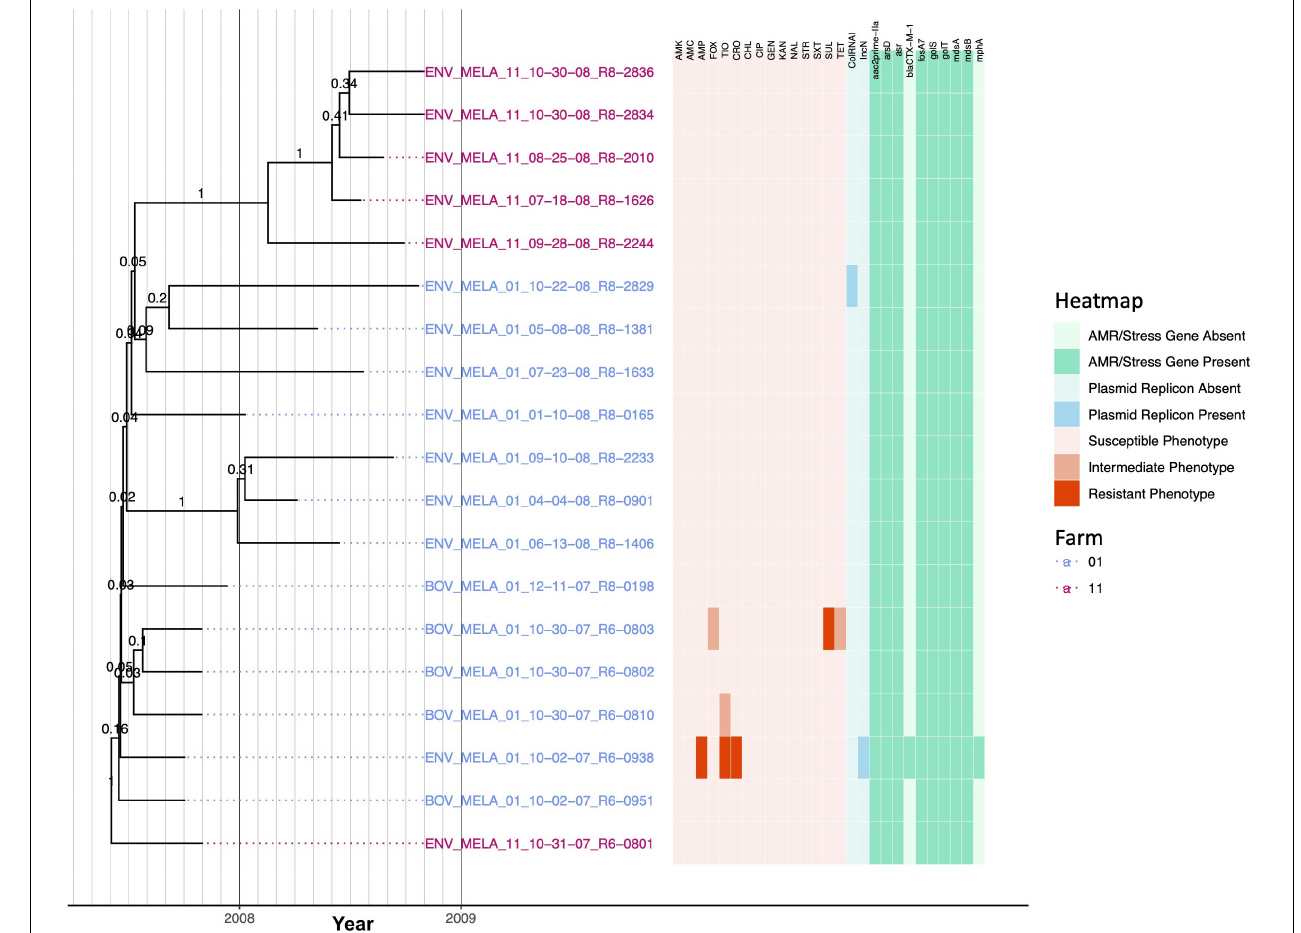
FIGURE 8 | Rooted, time-scaled maximum clade credibility (MCC) phylogeny constructed using core SNPs identified among 19 Salmonella Meleagridis genomes isolated from subclinical bovine sources and the surrounding bovine farm environment. Tip label colors denote the ID of the farm from which each strain was isolated. Branch labels denote posterior probabilities of branch support. Time in years is plotted along the X -axis, and branch lengths are reported in years. The heatmap to the right of the phylogeny denotes (i) the susceptible-intermediate-resistant (SIR) classification of each isolate for each of 15 antimicrobials (obtained using phenotypic testing and NARMS breakpoints; orange); (ii) presence and absence of plasmid replicons (detected using ABRicate/PlasmidFinder and minimum nucleotide identity and coverage thresholds of 80 and 60%, respectively; blue); (iii) presence and absence of antimicrobial resistance (AMR) and stress response genes (identified using AMRFinderPlus and default parameters; green). Core SNPs were identified using Snippy. The phylogeny was constructed using the results of ten independent runs using a strict clock model, the Standard_TPM2 nucleotide substitution model, and the Coalescent Bayesian Skyline population model implemented in BEAST version 2.5.1, with 10% burn-in applied to each run. LogCombiner-2 was used to combine BEAST 2 log files, and TreeAnnotator-2 was used to construct the phylogeny using common ancestor node heights. Abbreviations for the 15 antimicrobials are: AMK, amikacin; AMC, amoxicillin-clavulanic